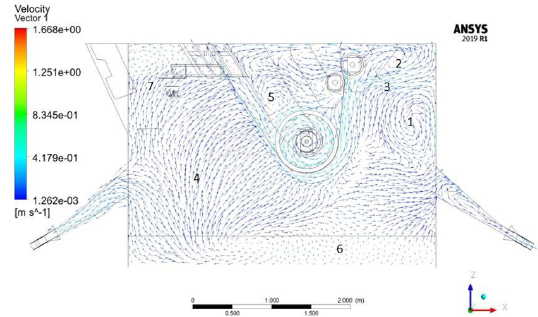
Figure 4. Top view of the pot used as a simulation model.